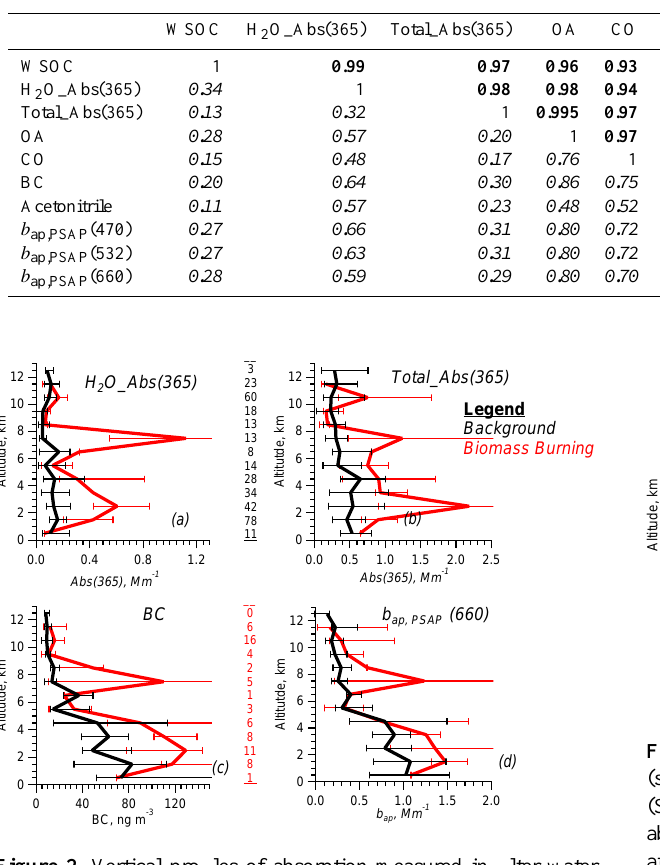
Figure 2. Vertical profiles of absorption measured in filter water extracts and the sum of water and methanol extract (total), both at 365nm, SP2 BC concentration, and PSAP absorption at 660nm. Data are binned into 1km ranges and the median values are shown. Error bars indicate inter-quartile ranges. The column in the middle shows the number of data points in each altitude bin, with black for background conditions (upper) and red for biomass burning (bottom row).